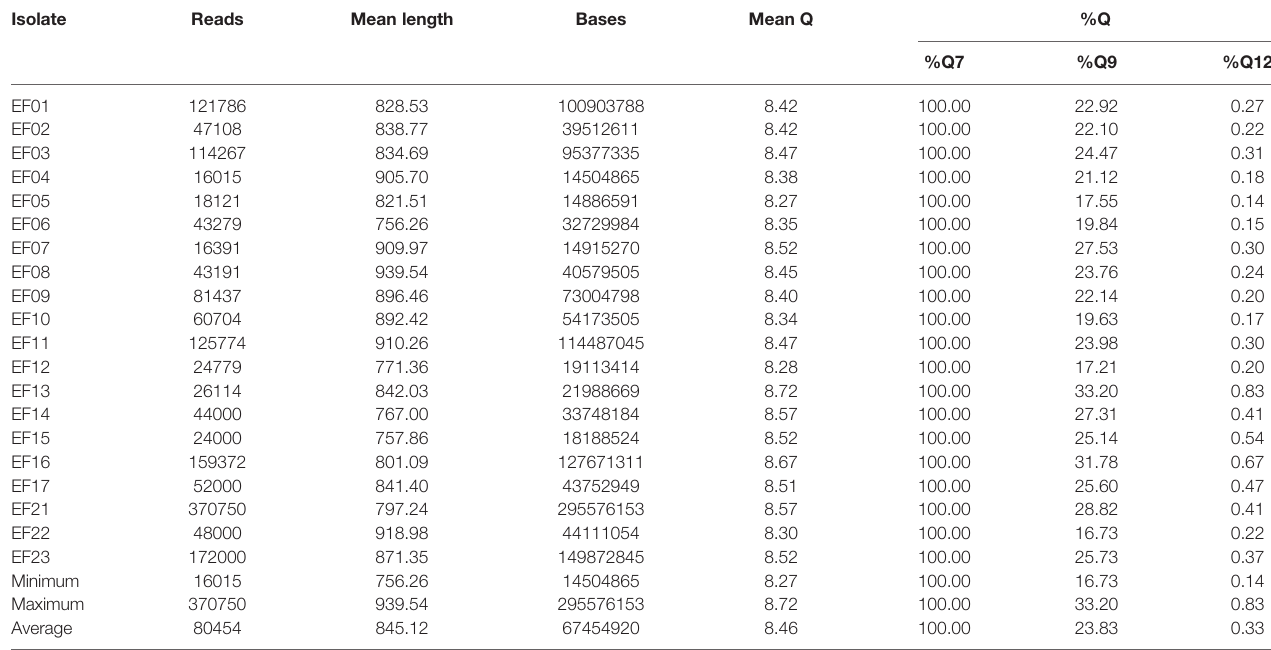
TABLE 2 | Quality control results of EPI2ME for the raw long-read next-generation sequencing